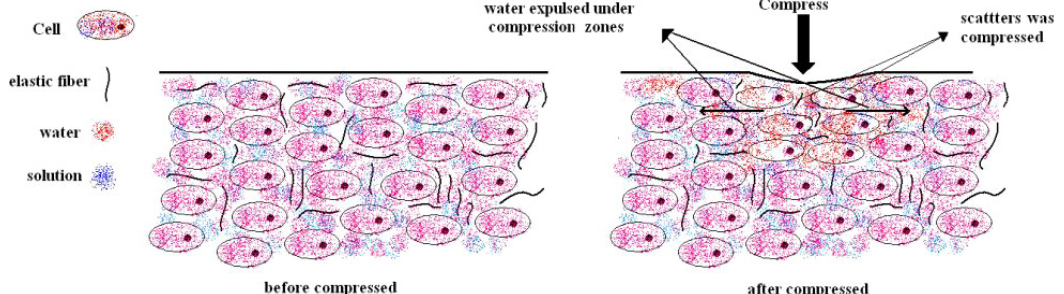
Fig. 2. Skin deformation and structural changes before and after compressed.